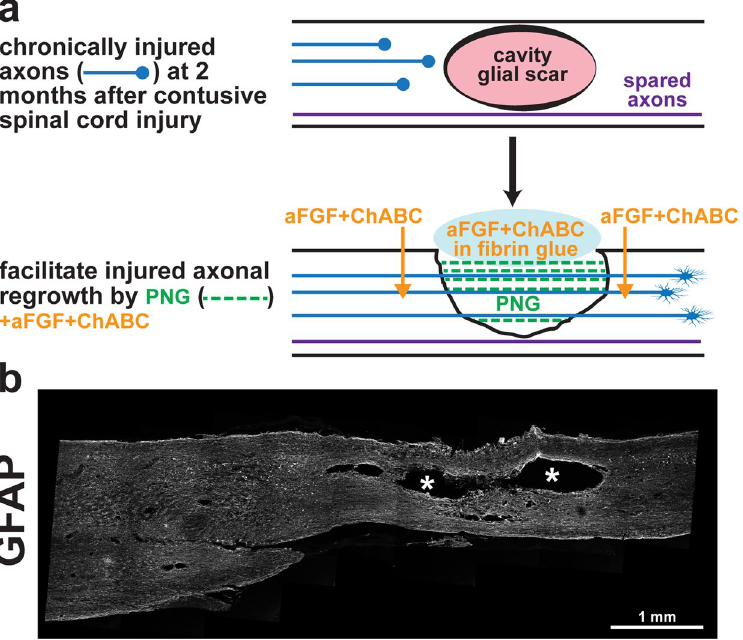
Figure 1. Surgical intervention to bridge the gap after chronic contusive SCI. ( a ) Schematic diagram illustrating the repair strategy. At two months post-injury, a cystic cavity forms at the injury site (pink oval, top drawing). For repair surgery, the cavity is exposed via the dorsal cord surface, scar tissue lining the cavity is gently removed, and several autologous peripheral nerve segments (green dotted lines, bottom drawing) are longitudinally placed in the cavity to span the lesion. aFGF + ChABC (orange) is injected rostrally, caudally, and at the sides of the spinal cord adjacent to the graft. A glue made of aFGF, ChABC, and fibrin is used to stabilize the graft (blue oval, bottom drawing). ( b ) GFAP-stained spinal cord two months post-contusion. Note the large cavity in the epicenter of the injured site, as indicated by *